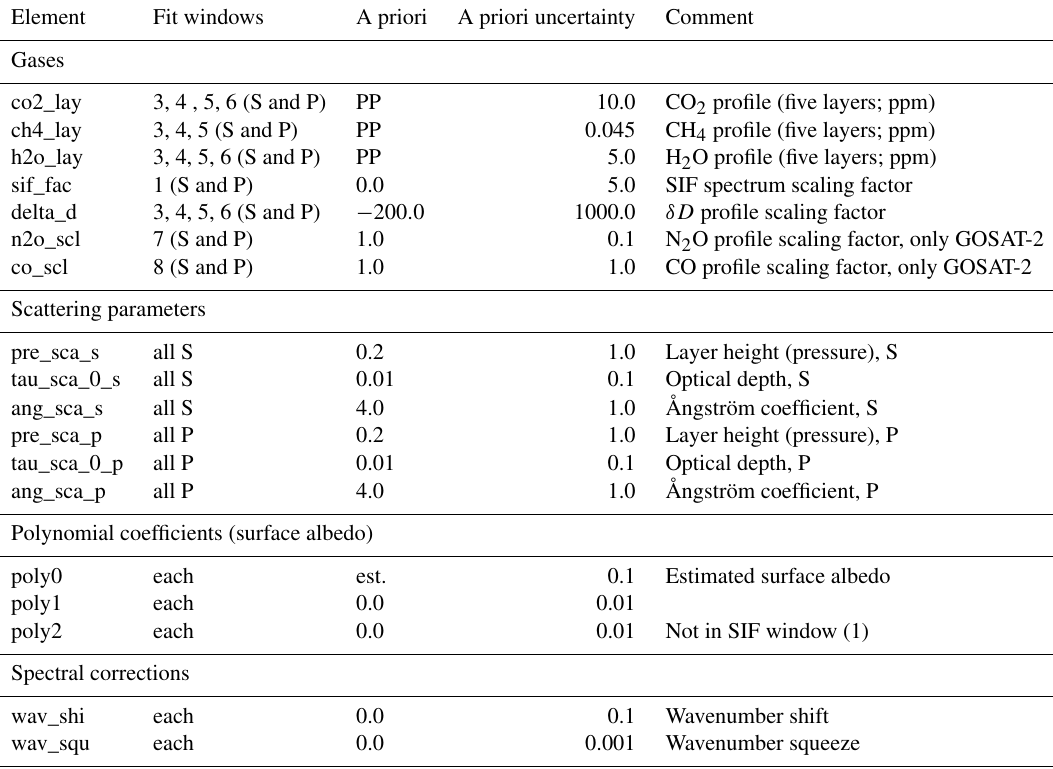
Table 5. State vector elements and related retrieval settings. A priori values are also used as a first guess. “Fit windows” lists the spectral windows (see Table 4) from which the element is determined. “All” means that an element is determined from all fit windows of the specified polarisation. “Each” means that a corresponding element is fitted in each fit window. A priori values labelled “PP” are taken from pre-processing; “est.” denotes that they have been estimated from the background